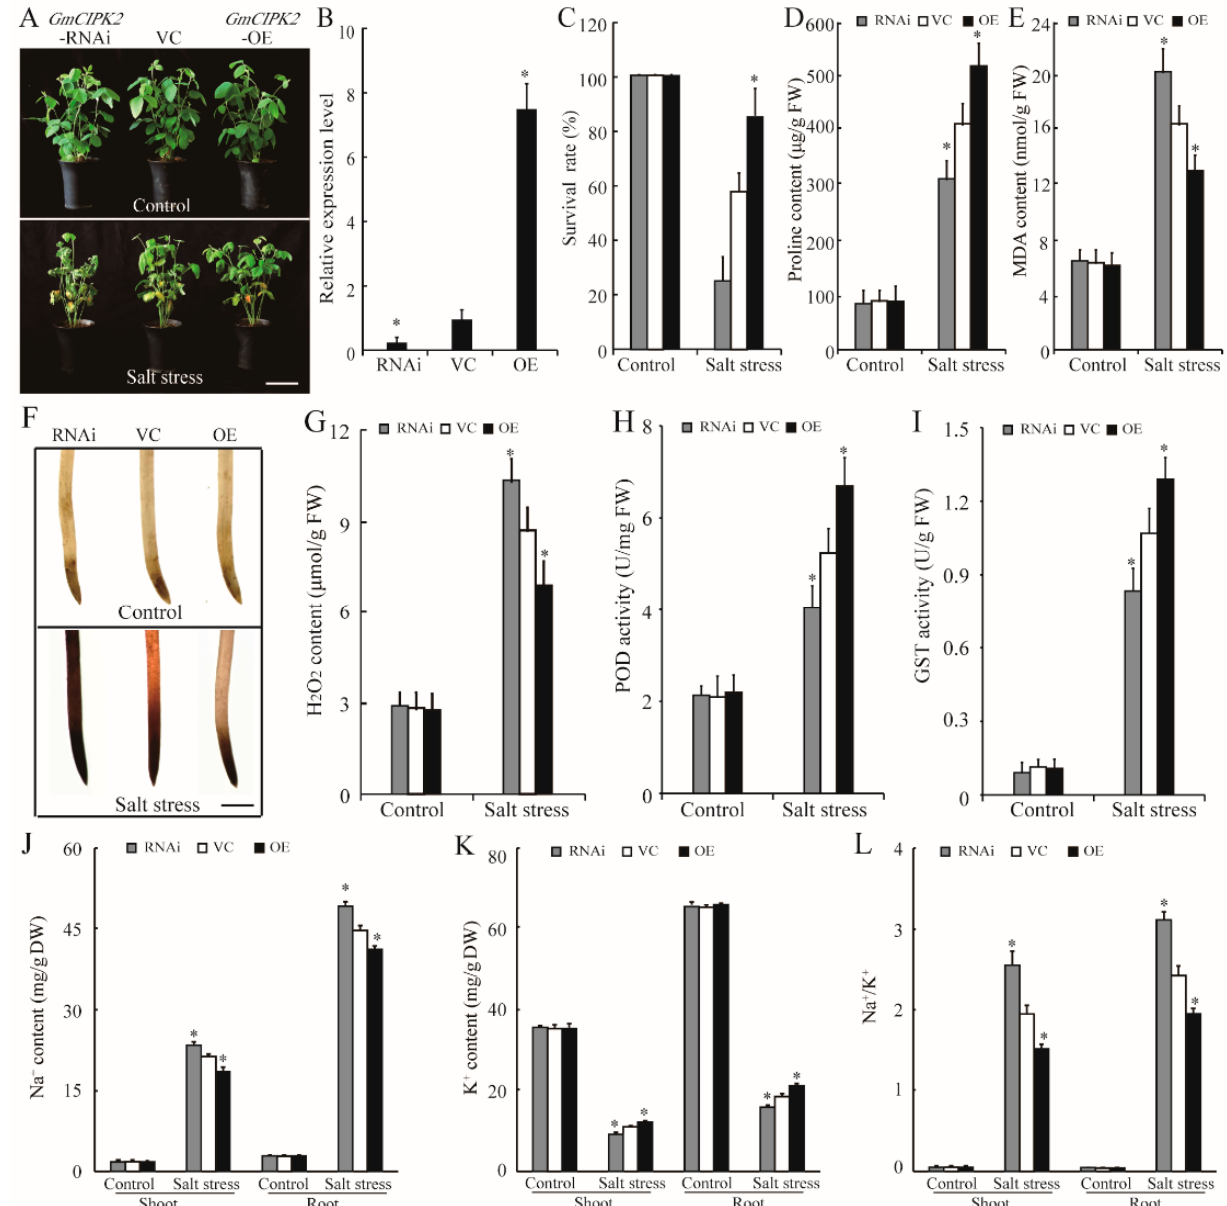
Figure 3. GmCIPK2 imparts salt tolerance in hairy roots of soybean. ( A ) Analyses of the salt tolerance in RNAi, VC, and OE plants under salt treatment. Bar = 10 cm. ( B ) The transcripts of GmCIPK2 were measured by qRT-PCR analysis. ( C ) Survival rates, ( D ) proline contents, ( E ) MDA contents, and ( F ) DAB staining of RNAi, VC, and OE hairy roots. Bar = 0.1 cm. ( G ) H 2 O 2 content measurement, ( H ) POD activity detection, ( I ) GST activity detection, ( J ) Na + contents, ( K ) K + contents, and ( L ) Na + /K + ratios of RNAi, VC, and OE plants under salt treatment. Each data point represents the mean (±SE) of three independent biological replicates. The * represents significant differences with the corresponding controls (* p < 0.05).